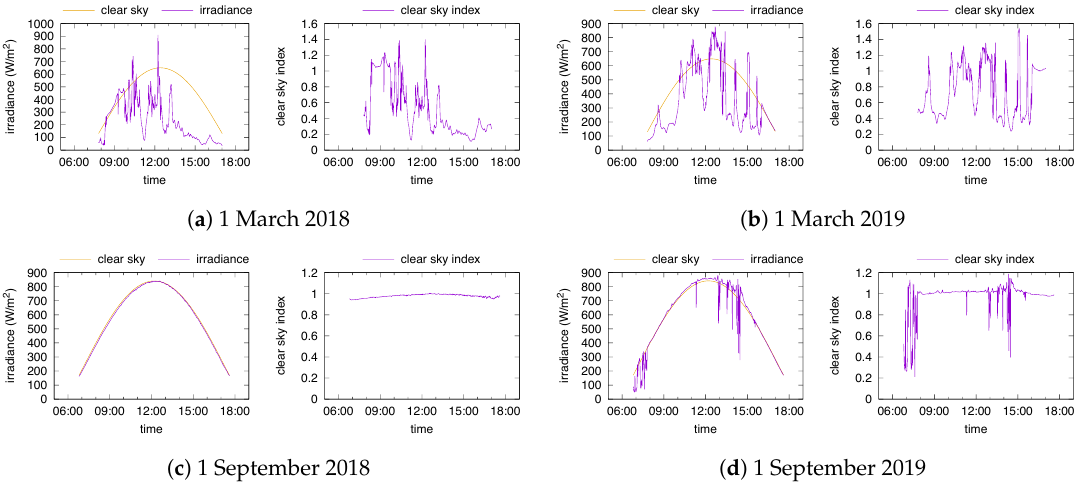
Figure 1. Global and clear sky irradiance ( left ) and clear sky index ( right ) in Portland for four selected days.